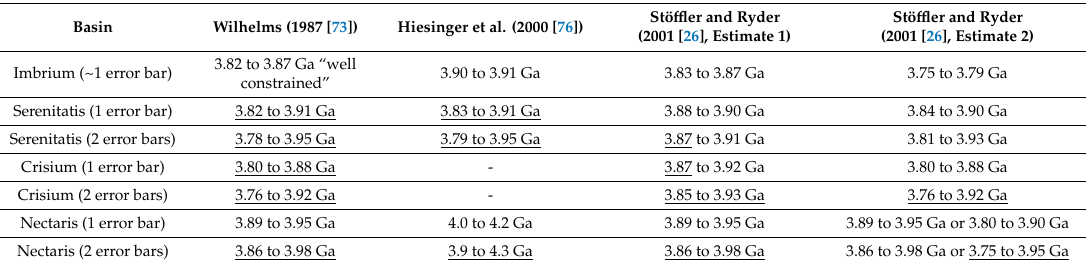
Table 3. Reported radiometric ages of Imbrium (Showing 1-error-bar age ranges) of Imbrium, compared to radiometric awithin 1, 2, 3 reported error bars (circa 2000) for three other lunar basins (Ga). (Underlined values overlap with Imbrium as listed in top line by the given